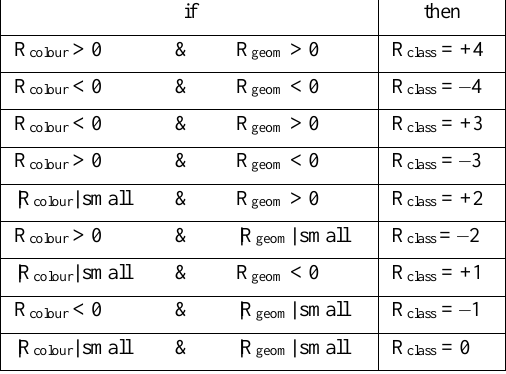
Table 1 . R class attribution